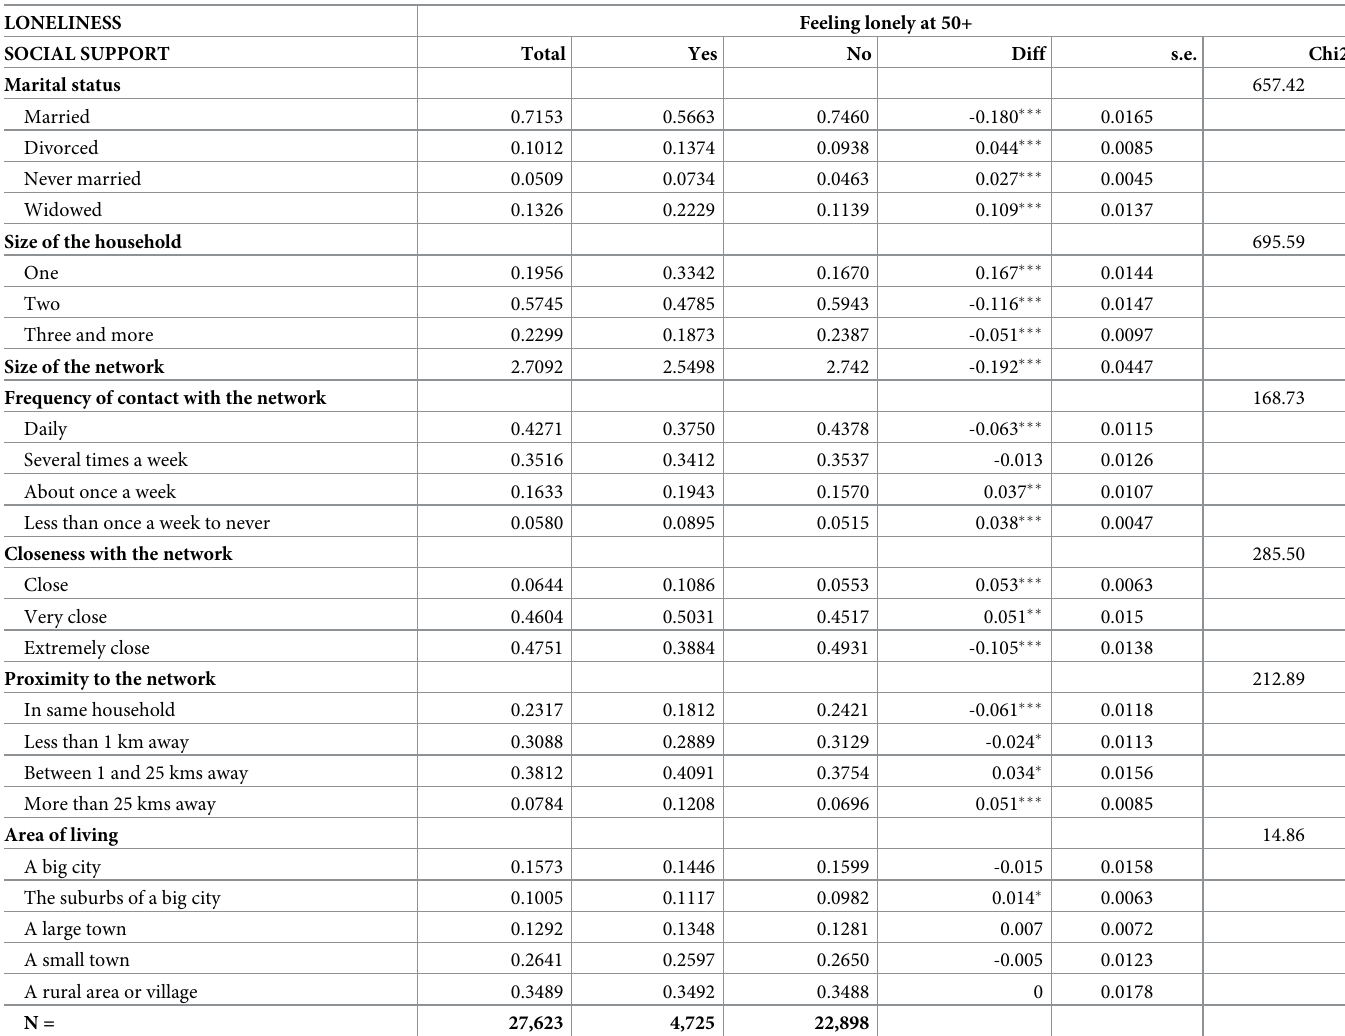
Table 3. Loneliness and social support at age